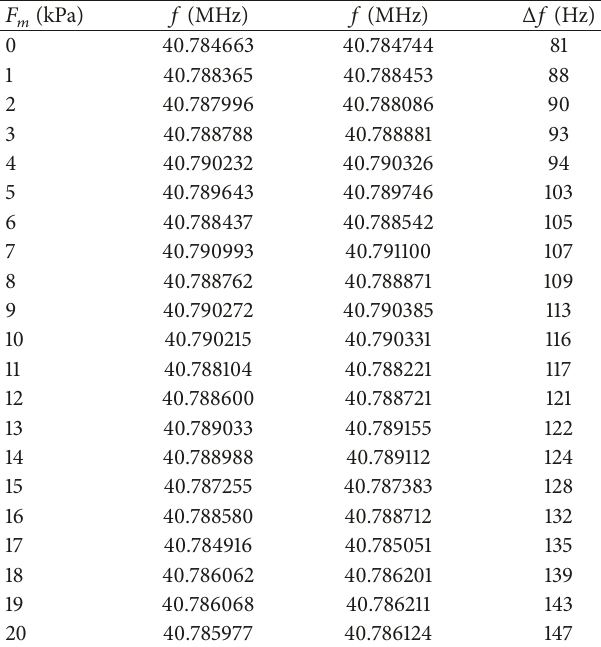
Table 1: Frequency and pressure experiment